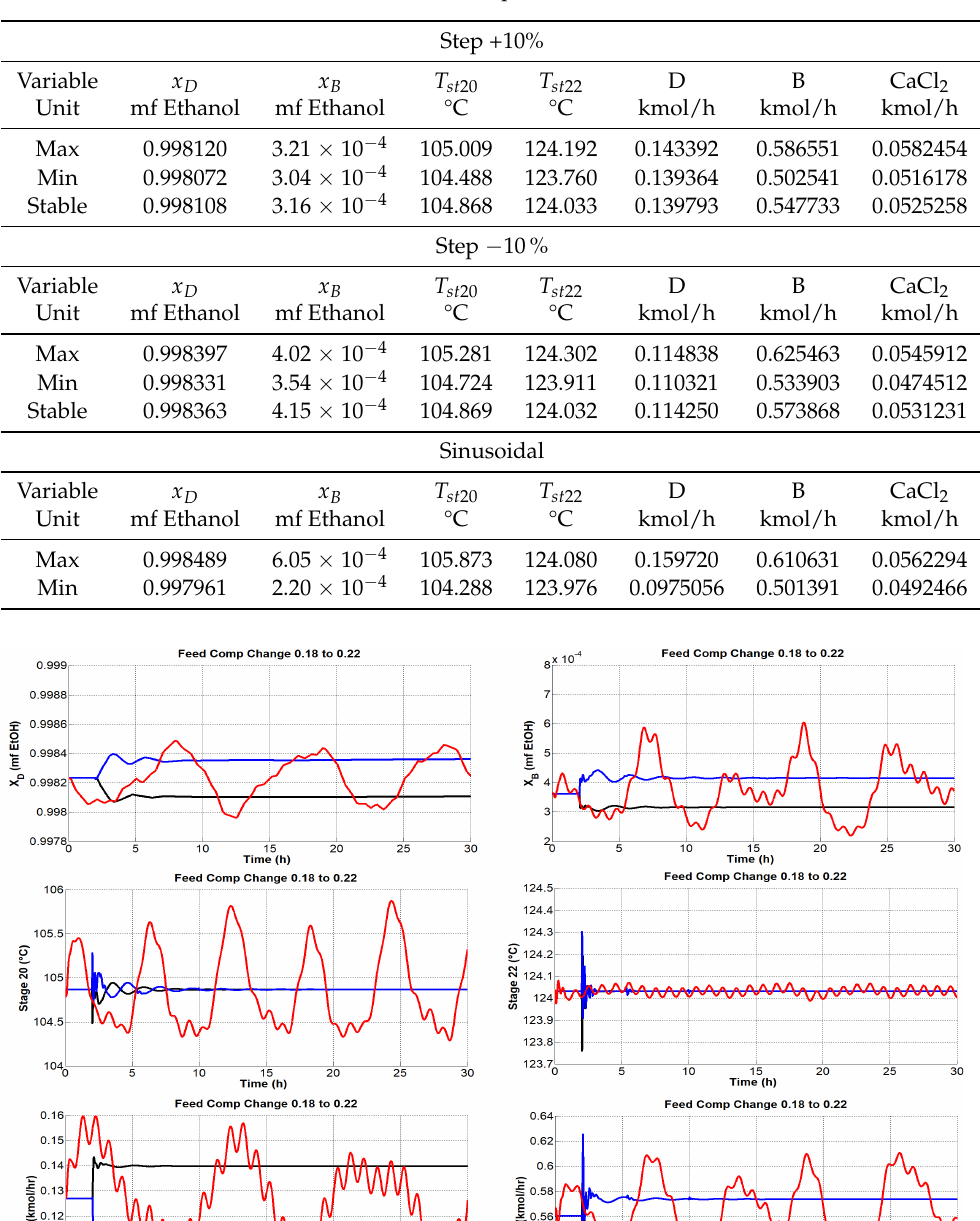
Table 9. The behavior of the process using the structure LV. Maximum, minimum, and stabilization values in the event of disturbances in the feed composition.